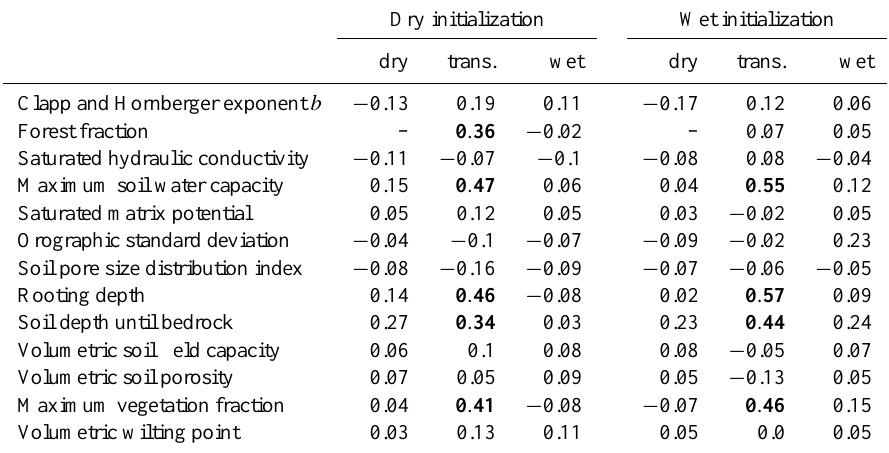
Table 2. Spatial June ensemble rank correlation coefficients between soil moisture τ 0 and static soil properties for different soil moisture regimes and initializations. Bold font indicates significant correlation ( p < 0 .